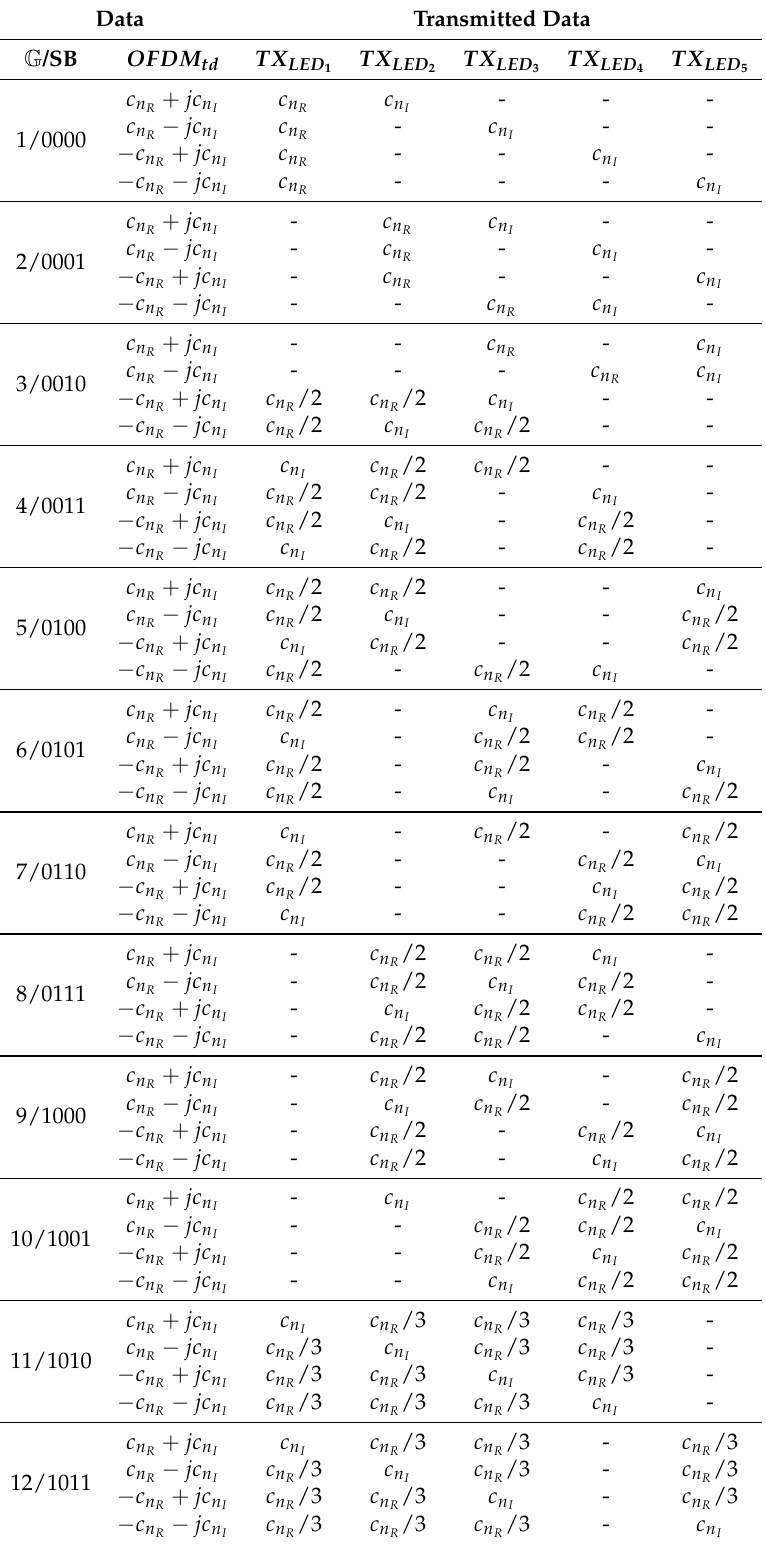
Table 2. Example for the ESI-LED transmission mechanism for n t =